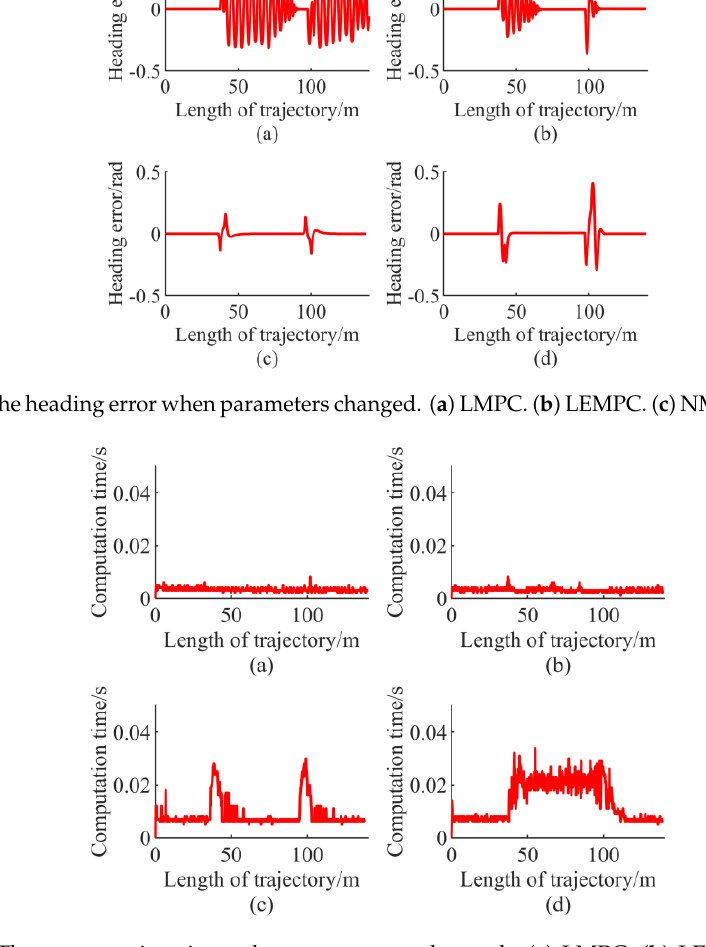
Figure 26. The computation time when parameters changed. ( a ) LMPC. ( b ) LEMPC. ( c ) NMPC. ( d ) NEMPC.